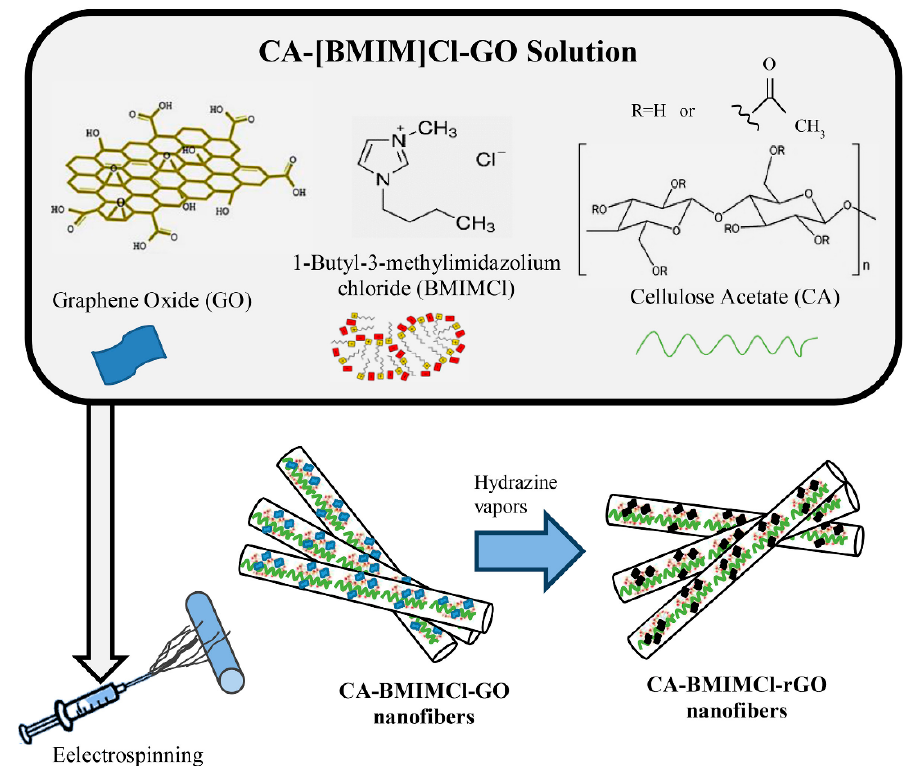
Figure 2. An electrospinning system combined cellulose acetate (CA), graphene oxide (GO) nanoparticles and 1-butyl-3-methylimidazolium chloride ([BMIM]Cl) to create conductive CA-[BMIM]Cl-GO nanofibers. The nanofibers were then converted to reduced GO nanofibers using hydrazine vapor to enhance the conductivity of the composite nanofibers [67]. Reproduced with permission from Elsevier,